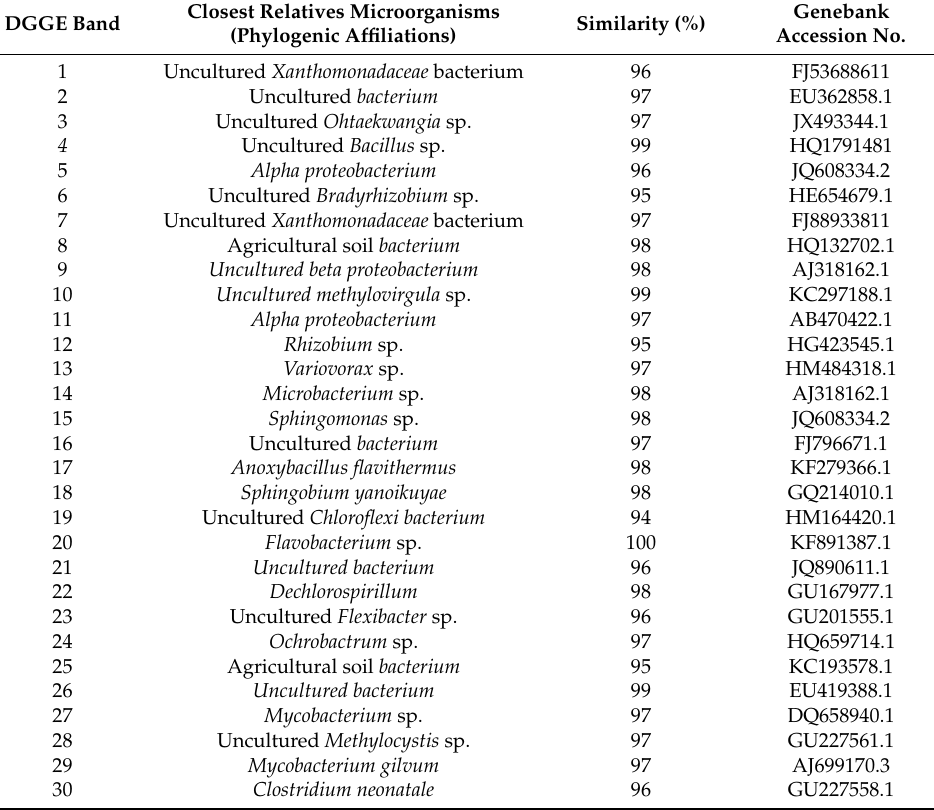
Table 4. Phylogeny of sequences present in the 16S rRNA amplicons